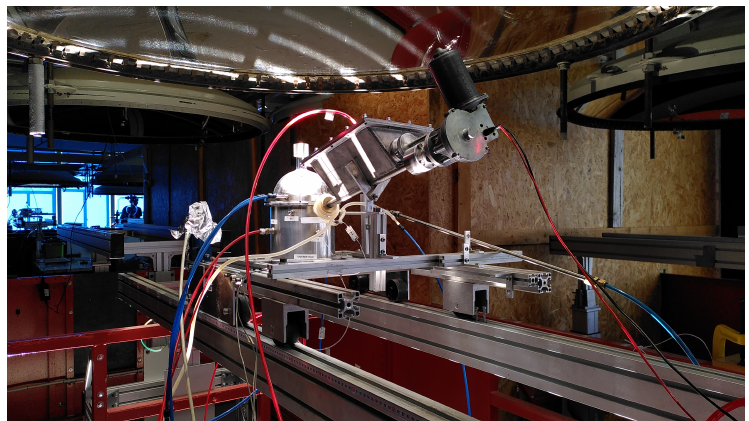
Figure 1. PROMES-CNRS’s solar reactor prototype (Odeillo,